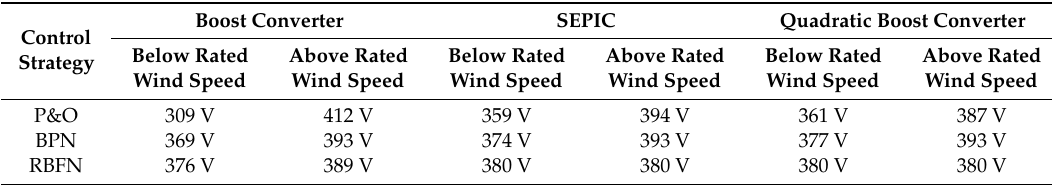
Table 4. Comparison of DC voltage obtained using boost, sepic and quadratic boost converters for different control